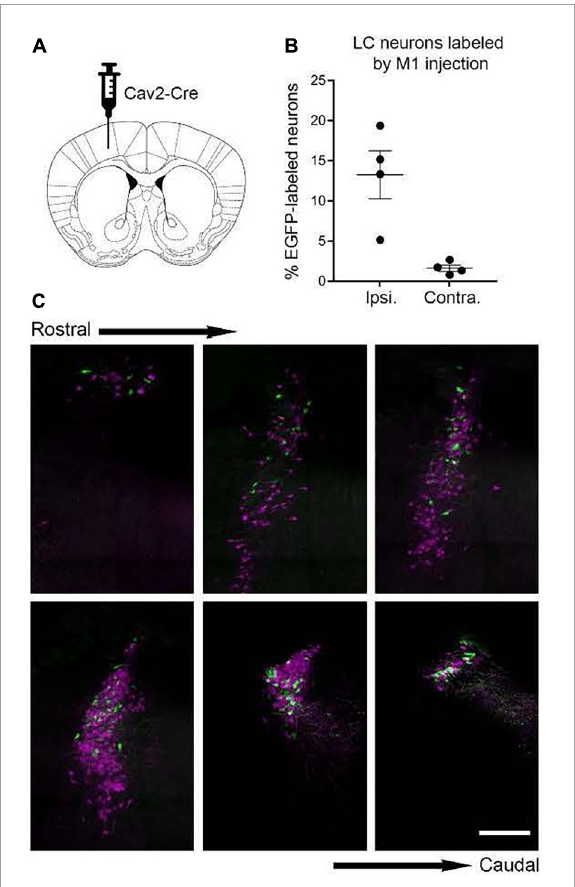
FIGURE2 Labeling of locus coeruleus neurons in TrAC-LC mice following CAV2-Cre injection in primary motor cortex (M1). (A) Coronal schematic of mouse forebrain section showing position of CAV2-Cre injection. (B) Bar graph showing percentage of EGFP-labeled LC neurons, ipsilateral and contralateral relative to the injection site ( n = 4 mice). (C) Representative coronal sections through the rostrocaudal extent of the ipsilateral LC showing distribution of EGFP-labeled (green) and tdTomato-labeled (magenta) cells. Scale bar, 200 µ m. Adapted from Plummer et al.